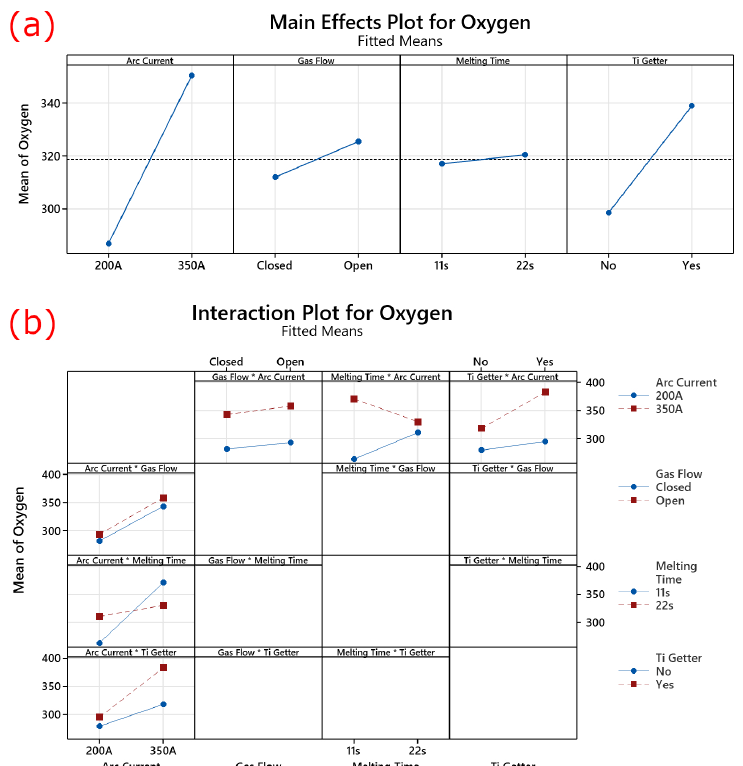
Cu Al Nb experiment plots for (a) main effects and (b) two-way 48 46.5 4 1.5